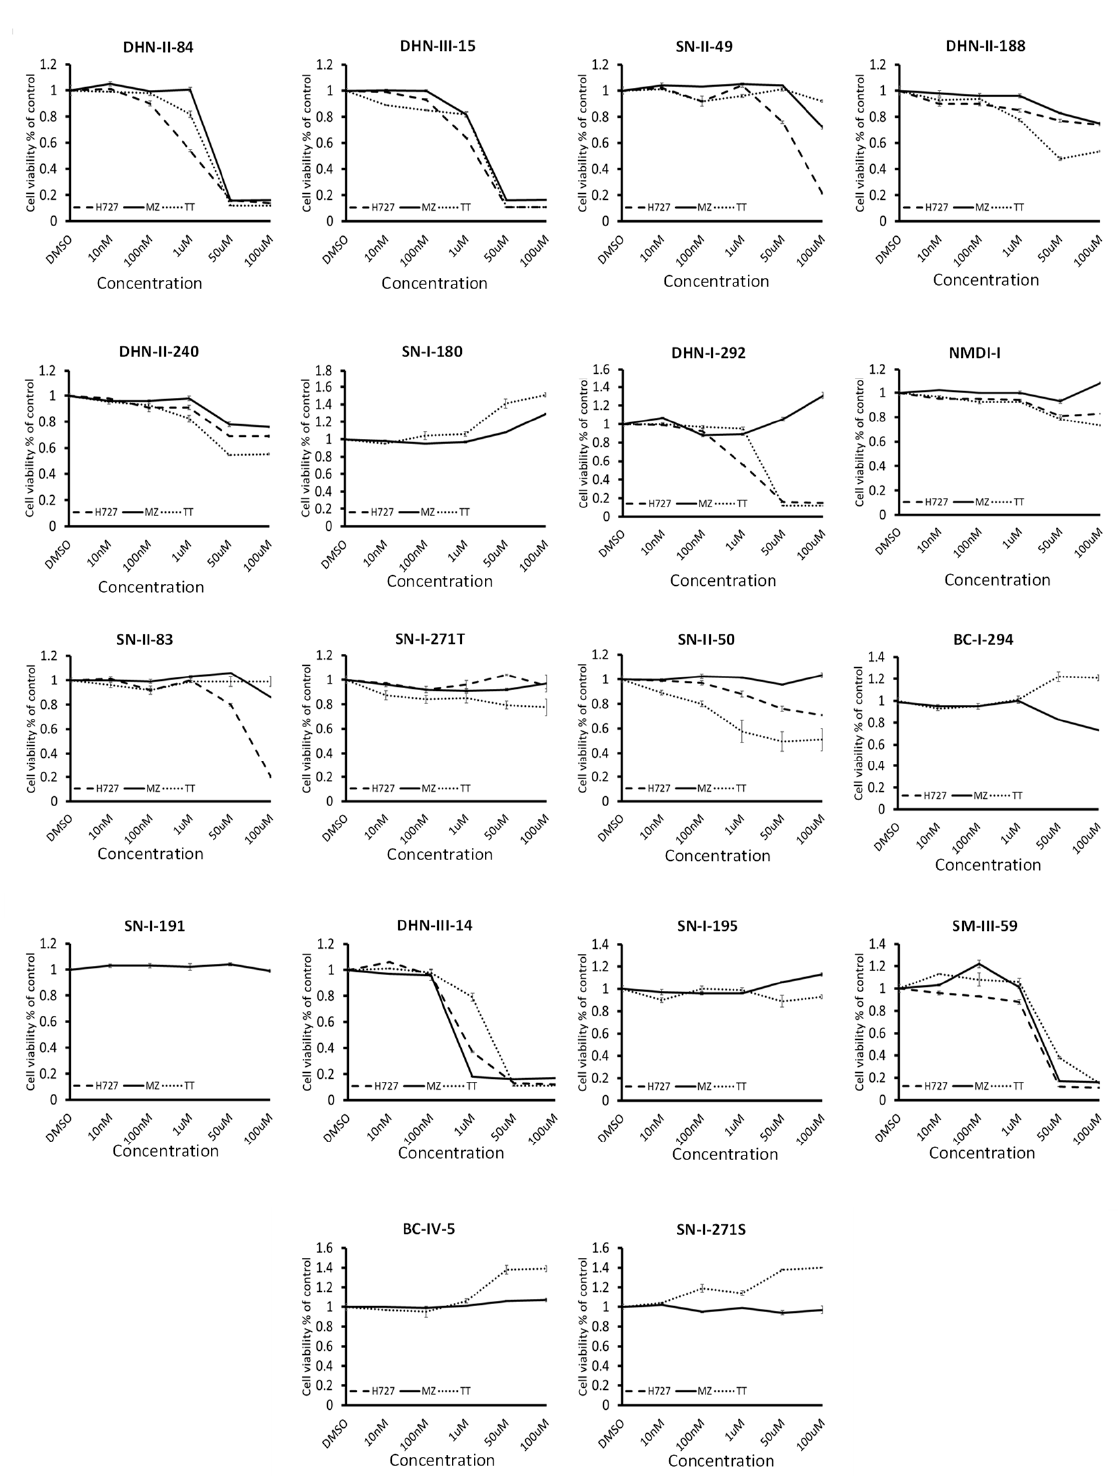
Figure 3. Test compounds showed varying degrees of cytotoxic e ff ects on neuroendocrine cell lines: H727, MZ-CRC-1 and TT in MTT assay. Experiments were performed in quadruplicates and data are plotted as mean ± SEM. Prominent e ff ects were displayed by DHN-II-84 and DHN-III-14. Table 1. Maximum efficacy and IC 50 values for the 18 compounds initially screened for anti-proliferative effects in three NET cell lines (H727, TT, MZ-CRC-1). Compound